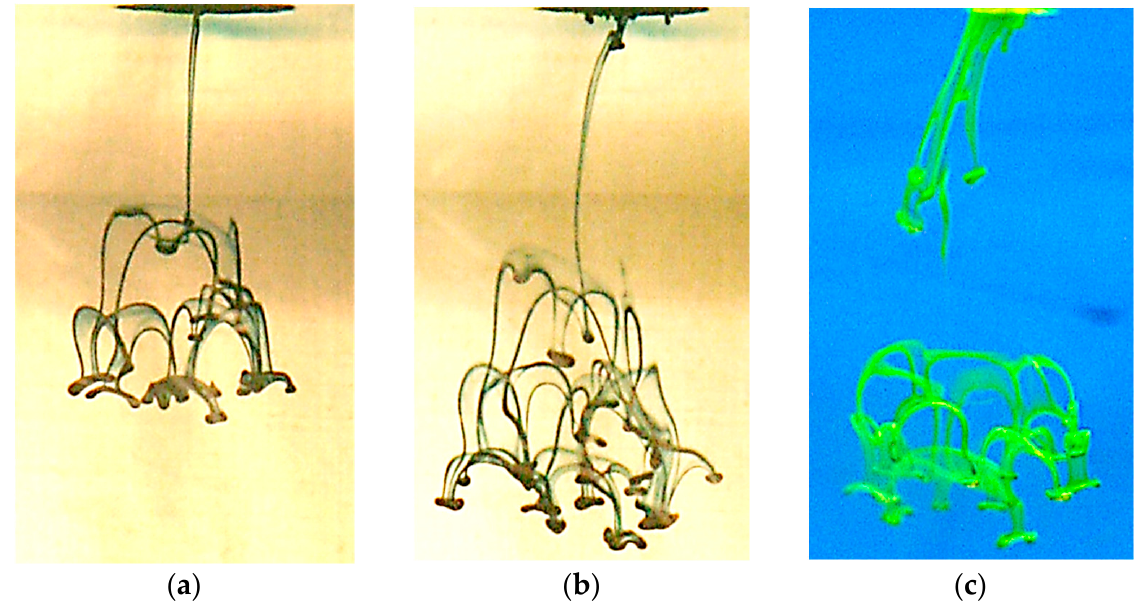
Figure 1. A cascade of vortices produced by dyed drop in tank with tap water: ( a , b )—a drop of blue alizarin ink solution, t = 12, 20 s, respectively; ( c )—a drop of uranine solution, t = 16 s.